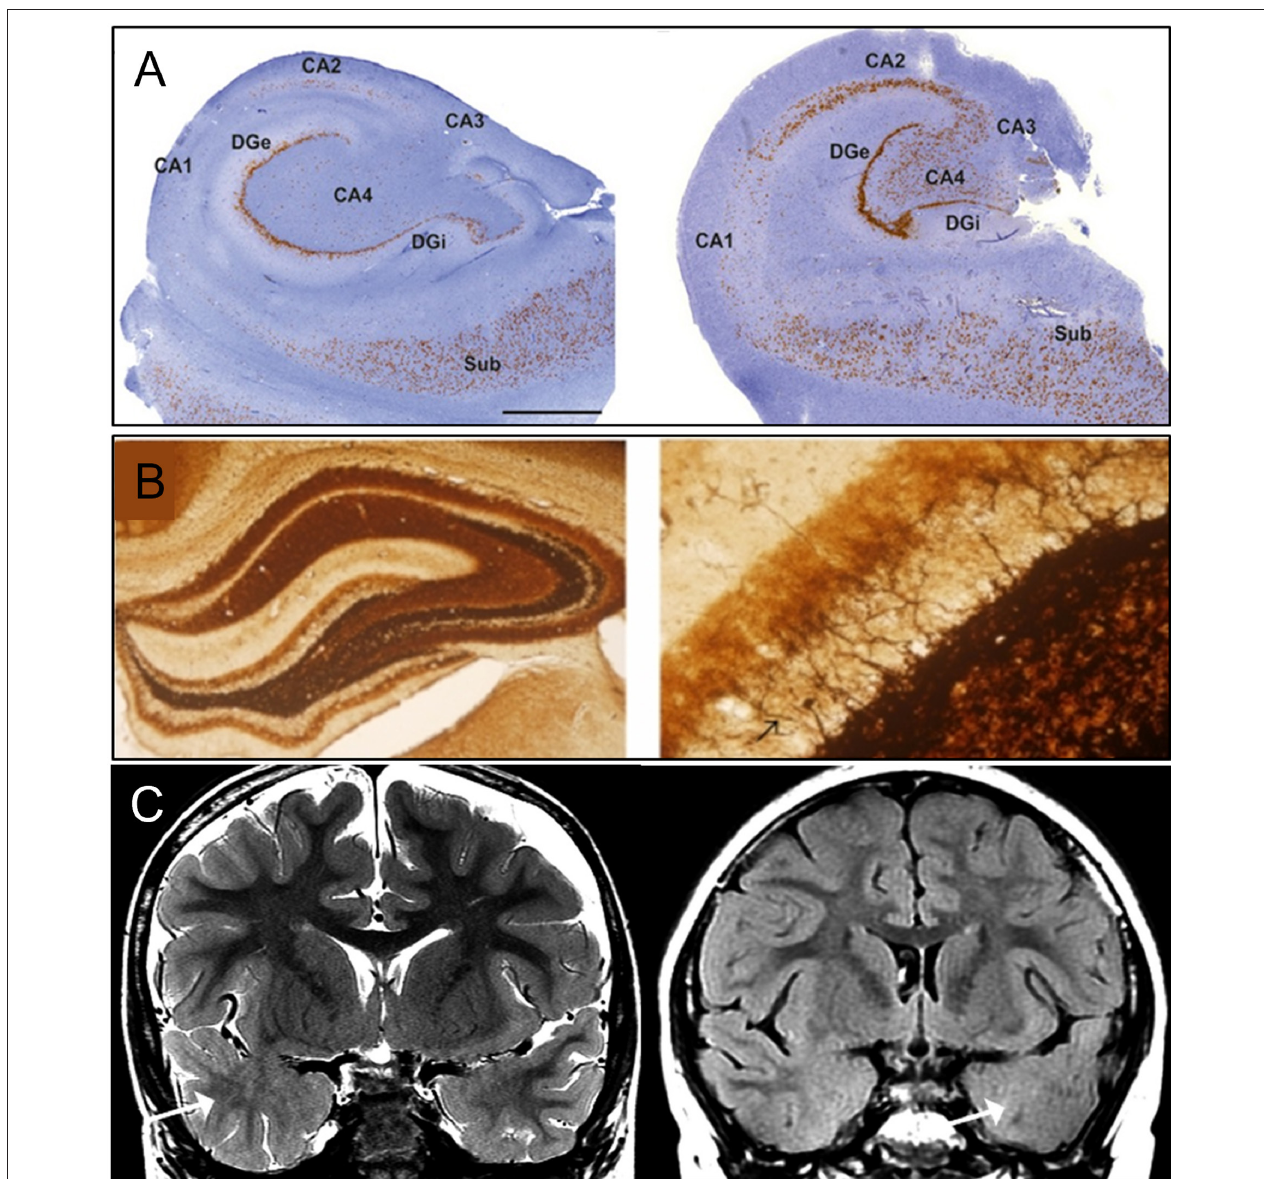
FIGURE 1 | Classical pathology of temporal lobe epilepsy. (A) Histology images of hippocampal sclerosis (HS) in patients with temporal lobe epilepsy (TLE), type 1 (left) and type 2 (right) (10). In type 1, cell loss in both CA4 and CA1 can be observed. Damage to CA3 and CA2 is also visible. Granule cell loss happens in the internal limb of dentate gyrus (DGi) with cell preservation in the subiculum (SUB). In type 2, neuronal loss primarily involving CA1. (B) Mossy fiber sprouting under Timm’s stain in KA-induced epileptic seizure rats (11), 40X (left) and 400X (right) with back arrow pointing to mossy fiber. (C) MRI imaging of focal cortical dysplasia (FCD) in two patients with TLE (12). Coronal T2-weighted imaging (left), and coronal T2-fluid-attenuated inversion recovery (FLAIR) sequence (right) images through the temporal lobes demonstrating asymmetric hyperintense temporal white matter signal and regional obscuration of corticomedullary interfaces in the temporal tip representing cortical dysplasia (Arrow). Figures were modified with